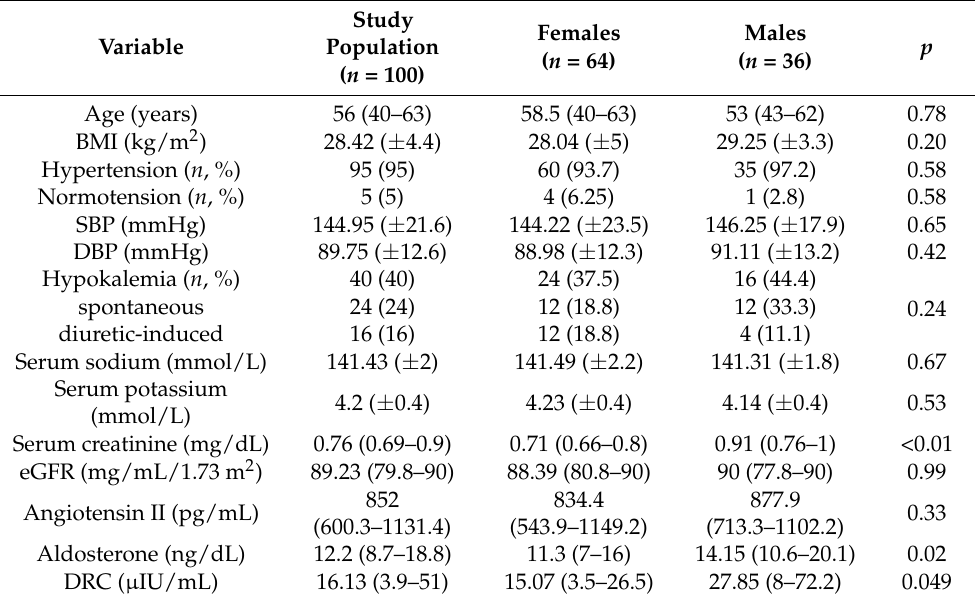
Table 1. Clinical and biochemical characteristics of the study cohort—comparison between females and